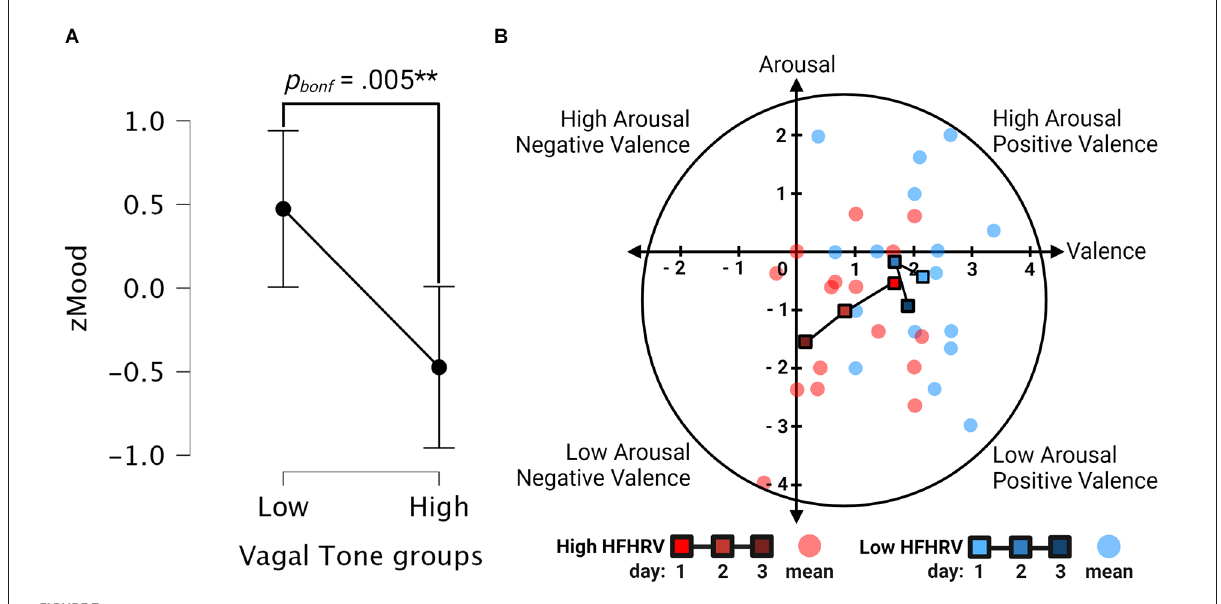
FIGURE7 Interval and valence arousal plots. (A) Interval plot for differences in mood between high and low HFHRV groups. Whiskers are 95% confidence intervals. (B) Valence-arousal plots for high (red) and low (blue) HFHRV groups. Line with squares indicates HFHRV group-means per day. Colors are the brightest for day 1 and darkest for day 3 of the exercise. Transparent circles indicate the mean for all 3 days for each participant.